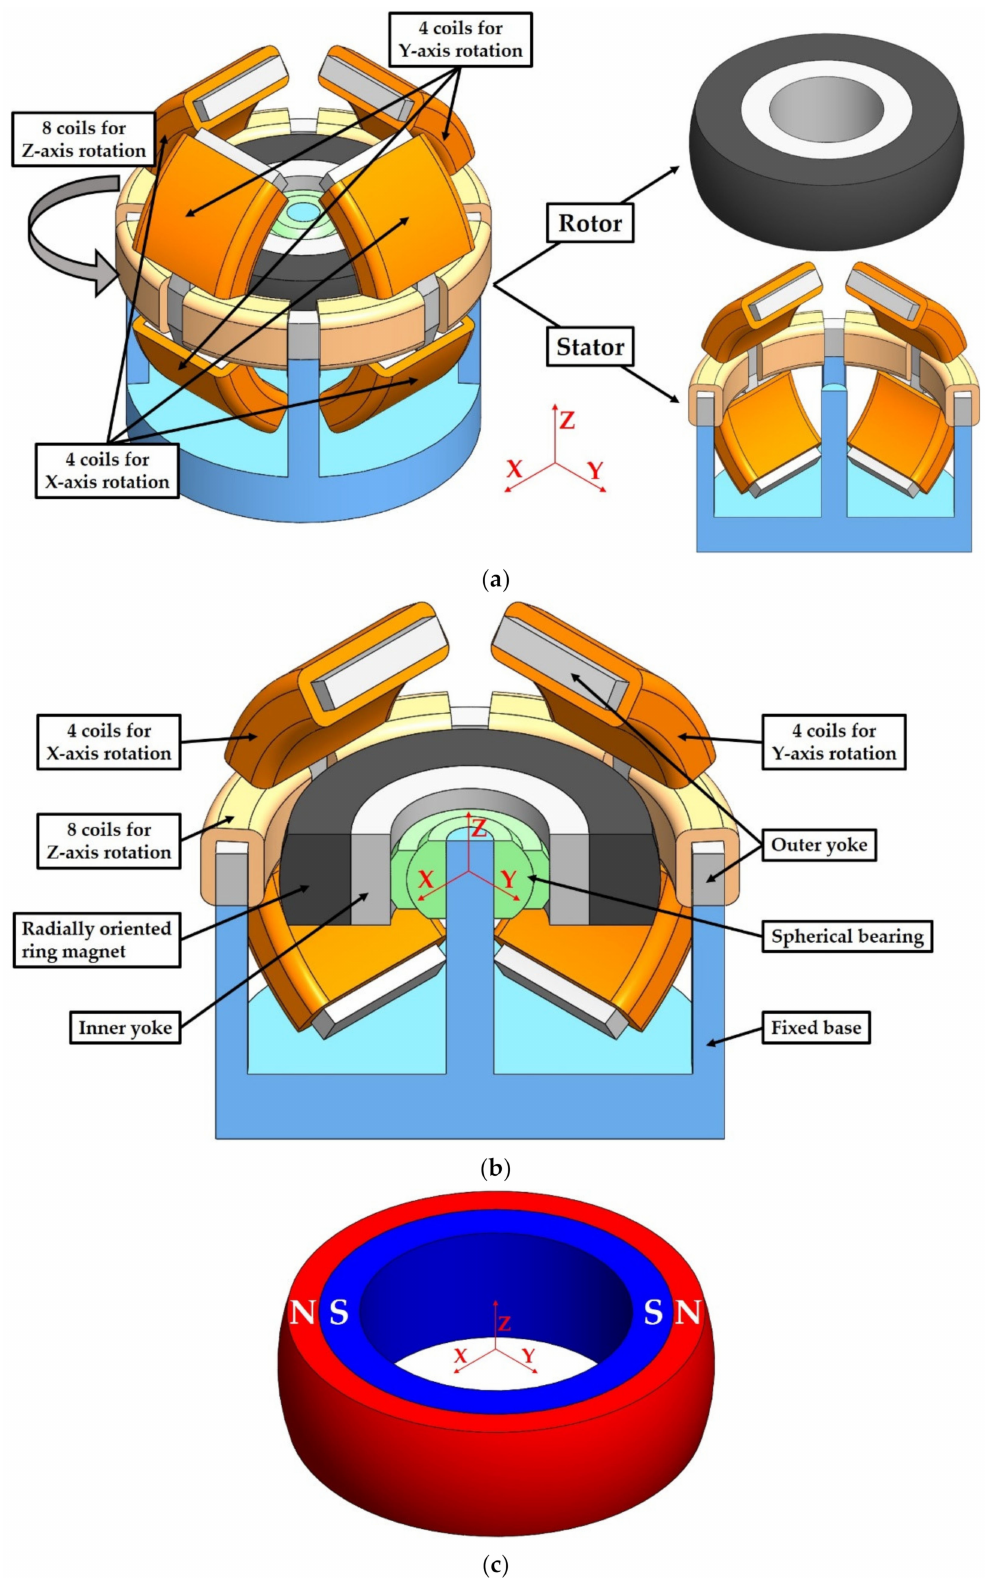
Figure 1. ( a ) The basic structure of the proposed 3-DOF spherical VCM; ( b ) detailed components; ( c ) radially oriented ring